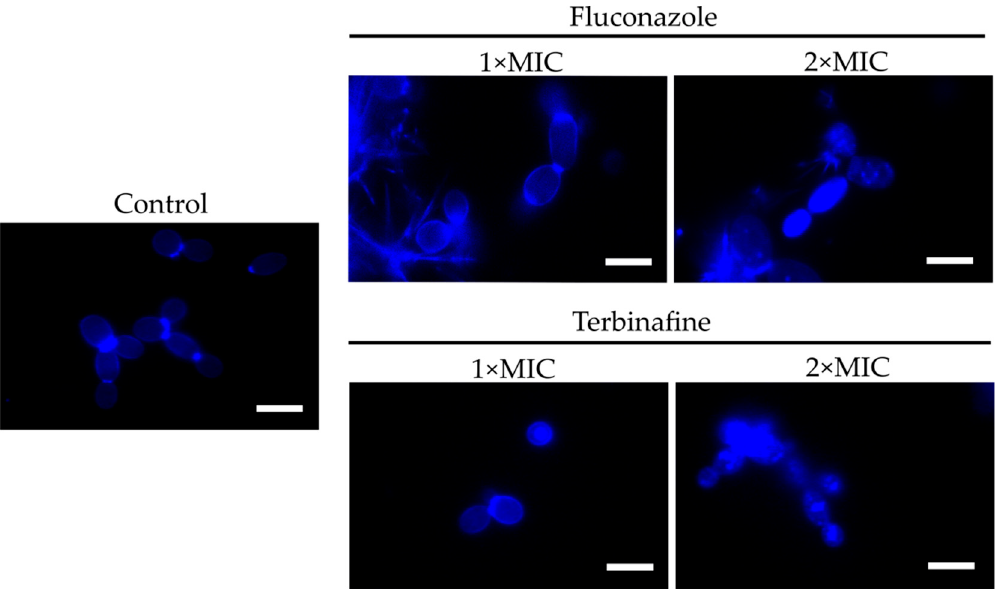
Figure 6. CLSM of C. albicans cells stained for 30 min with F145 alone (control), or after 4 h pre-treatment with either fluconazole or terbinafine (1× or 2× MIC) as indicated. Scale bar is 2 μ m.